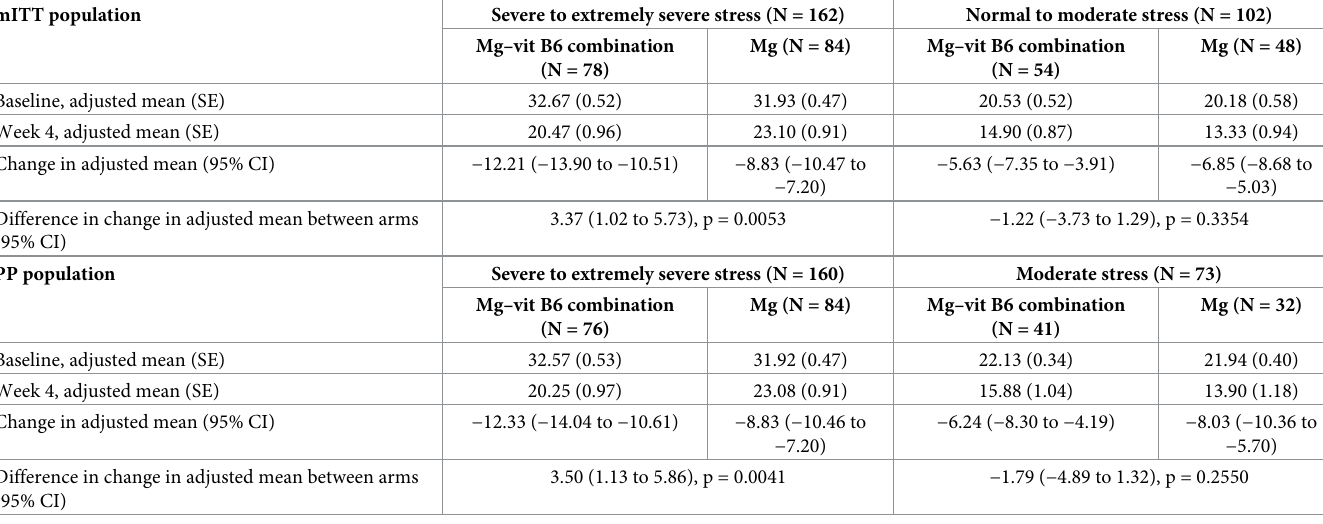
Table 4. Change in DASS-42 stress subscale score from baseline to Week 4 by DASS-42 subscale subgroup score at